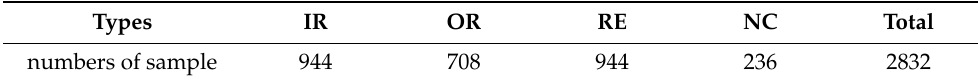
Table 5. Sample numbers of faulty and normal conditions.